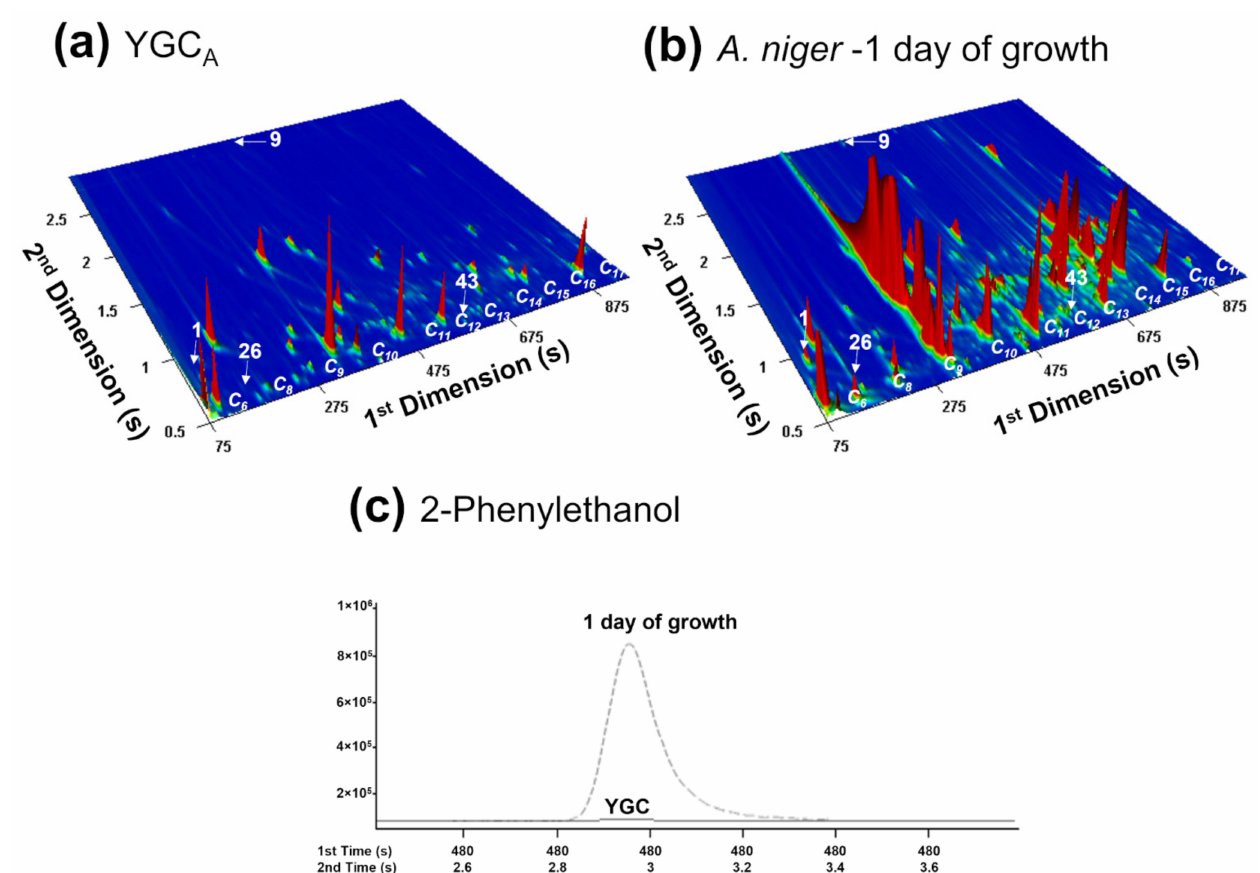
Figure 2. GC × GC-ToFMS total ion chromatogram contour plot of the VOCs released from: ( a ) Yeast Glucose Chloram- phenicol Agar medium (YGC A ), used as control and ( b ) A. niger culture headspace volatile components inoculated in YGC A , for 1 day of growth, at 37 ◦ C. ( c ) The wide 2-phenylethanol GC × GC peak was identified at a mass spectral acquisition of 100 spectra/s for 1 day of growth and absent for the YGC A . Peak number assignment in Table S1 and bold in Table